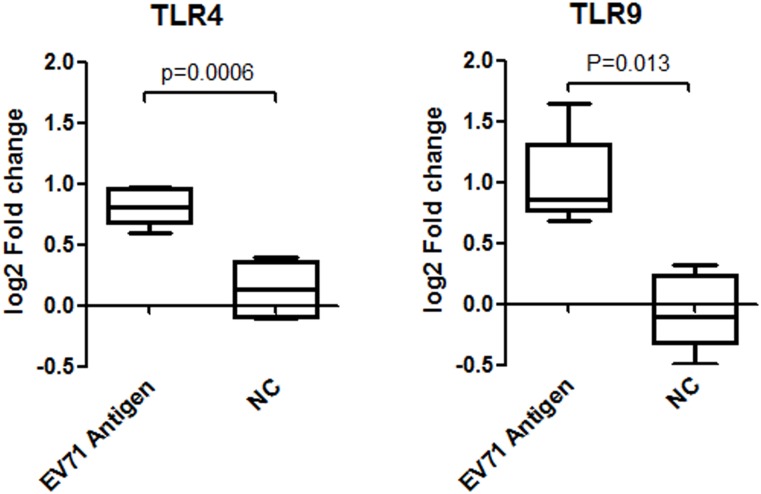
TLR4 and TLR9 mRNA expression after stimulated with EV71 inactivated liquid bulk in vitro.TLR4 mRNA expression was tested by q-PCR at 48h after incubation with 100U/ml EV71 inactivated liquid bulk, while TLR9 was measured at 9h. Significantly increased expression of TLR4 mRNA (n = 5, fold increase = 1.76 p = 0.0061) and TLR9 mRNA (n = 5, fold increase = 1.91, p = 0.0013) was observed in mice spleen lymphocytes after stimulation with EV71 inactivated liquid bulk.